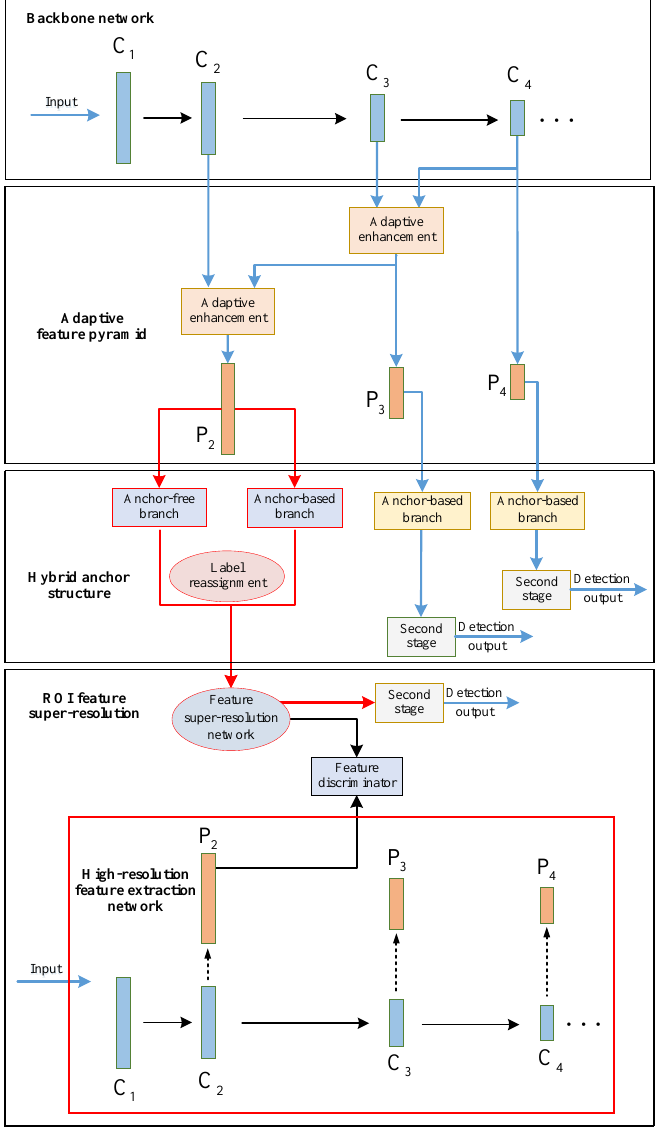
Figure 1. The pipeline of the proposed